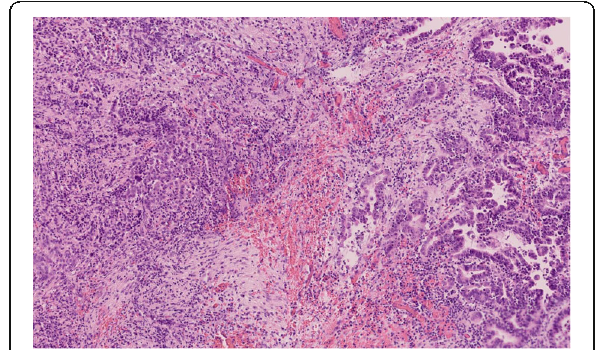
Fig. 4 Transition between Intraductal Pancreatic Mucinous Neoplasm (IPMN) and Pancreatic Medullary Carcinoma (PMC). From right to left, the transition between pancreatobiliary-type IPMN in high-grade dysplasia, infiltrative glands and poorly differentiated epithelial cells of the invasive cancer (HE